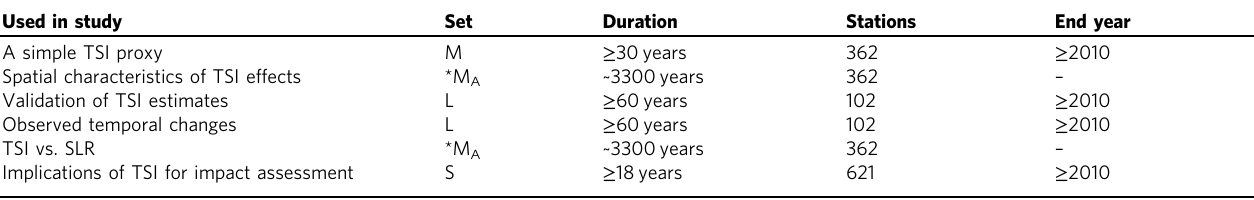
Table 1 Data set characteristics and